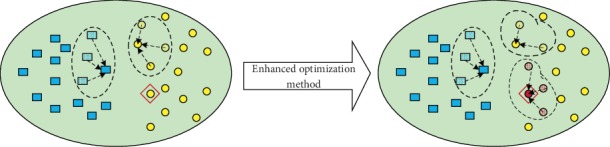
Case (ii): xα is not an exemplar.